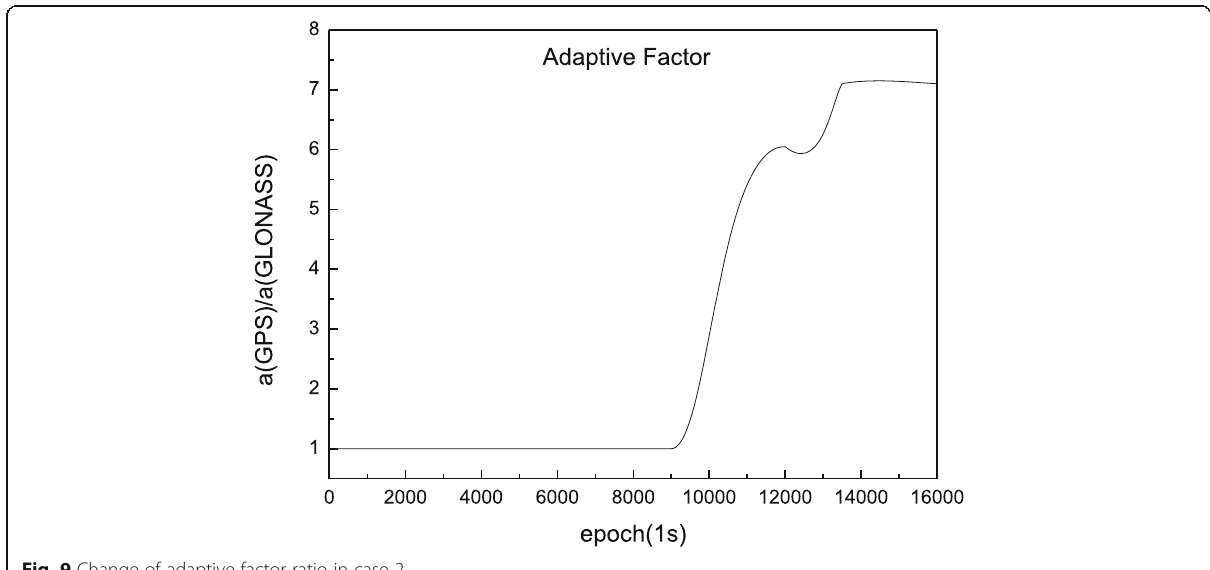
Fig. 9 Change of adaptive factor ratio in case 2